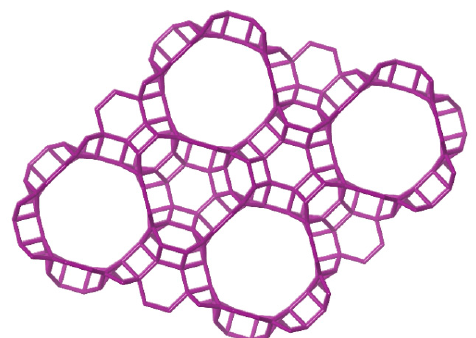
Figure 4. ETR framework overview containing large cages with ring size of 18-T atoms; (the image is produced by 3D drawing tool in database of zeolites structures, Accessed 17 March 2022) [78]. 4. Application of the SDAs in the Formation of Microporous Zeolites The relation between the size and geometry of SDA molecules and the final configu- ration of generated cavities is attributed to the interactions between the SDA and inor- ganic framework of zeolites, by which the rotation of SDA inside a forming pore is pro- hibited by negatively charged species [79]. In this regard, small and spherical molecules can form Clathrasils possessing polyhedral cavities with small windows, which are not large enough for bulky molecules to pass through them easily [80]. Larger branched mol- ecules such as quaternary ammonium molecules (e.g., TMA + , TEA + , etc.) possess rigid structures and mainly generate 3D zeolites (e.g., MFI or BEA topology, Figure 5), while linear diquaternary cations such as hexamethonium cation are flexible species and gener- ate 1D porous networks such as ZSM-48 and EU-1 (* MRE and EUO framework, respec- tively) [81,82].